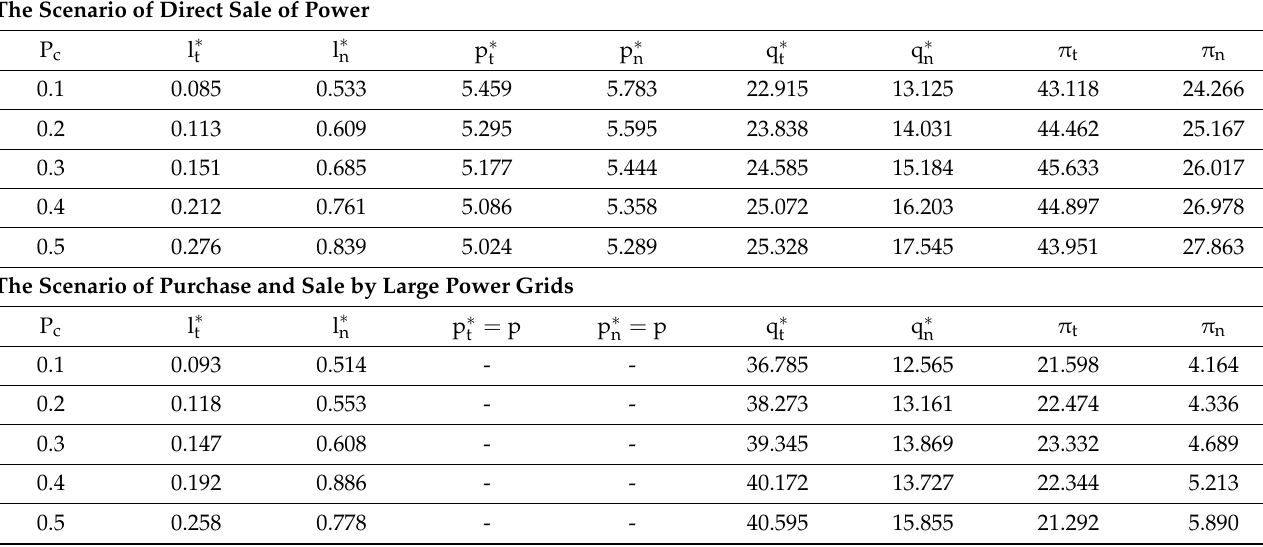
Table 2. Impact of green power certificate price on the investment and production of renewable